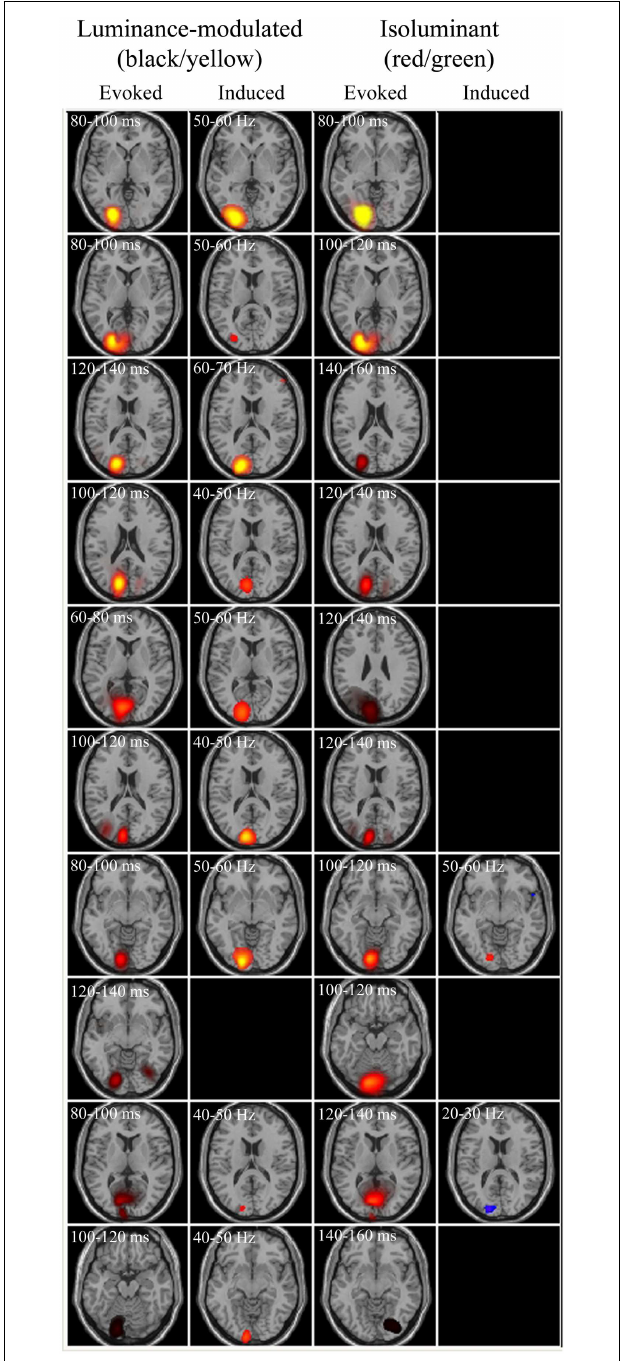
FIGURE 5 | Evoked and induced responses for each observer to luminance-modulated and isoluminant stimuli at 3 cpd. Axial slices are through the peak activations. Each row represents an observer, with observers ranked in order of the largest evoked responses. Blue/purple colors depict energy decreases and orange/yellow colors depict energy increases. All evoked panels have an arbitrary color range of 500–5. Colors in the induced panels indicate the amplitude of the pseudo- T statistic (2 ≤ T ≤